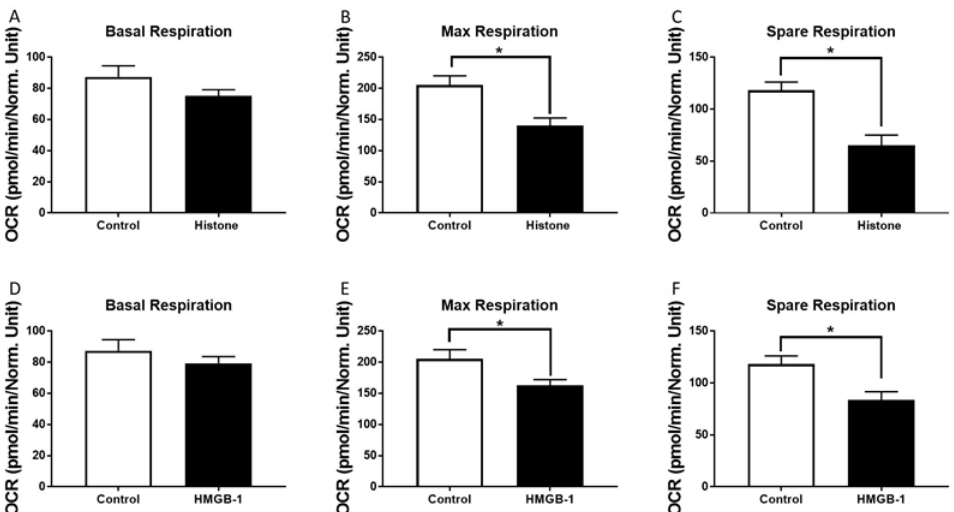
Figure 3. Metabolic alterations of human cardiomyocytes (CM) in the presence of histones: Basal respiration (OCR in pmol / m in / Norm. unit) of human CMs in the presence of 20 µ g / mL histones (37 °C, 6 h) ( A ). Maximal respiratory capacity (OCR in pmol / m in / Norm. unit) of human CMs in the presence of 20 µg/mL histones compared to the control (PBS) ( B ). Spare respiration (OCR in pmol/m in/Norm. unit) of human CMs in the presence of 20 µg/mL histones (37 ◦ C, 6 h) ( C ). Basal respiration ( D ), max respiratory capacity ( E ) and spare respiration ( F ) of human CM in the presence of 100 ng/mL HMGB-1. Results are presented as mean SEM, for all experiments n = 6. Results are significant * p < 0.05, statistical analysis with t-test.